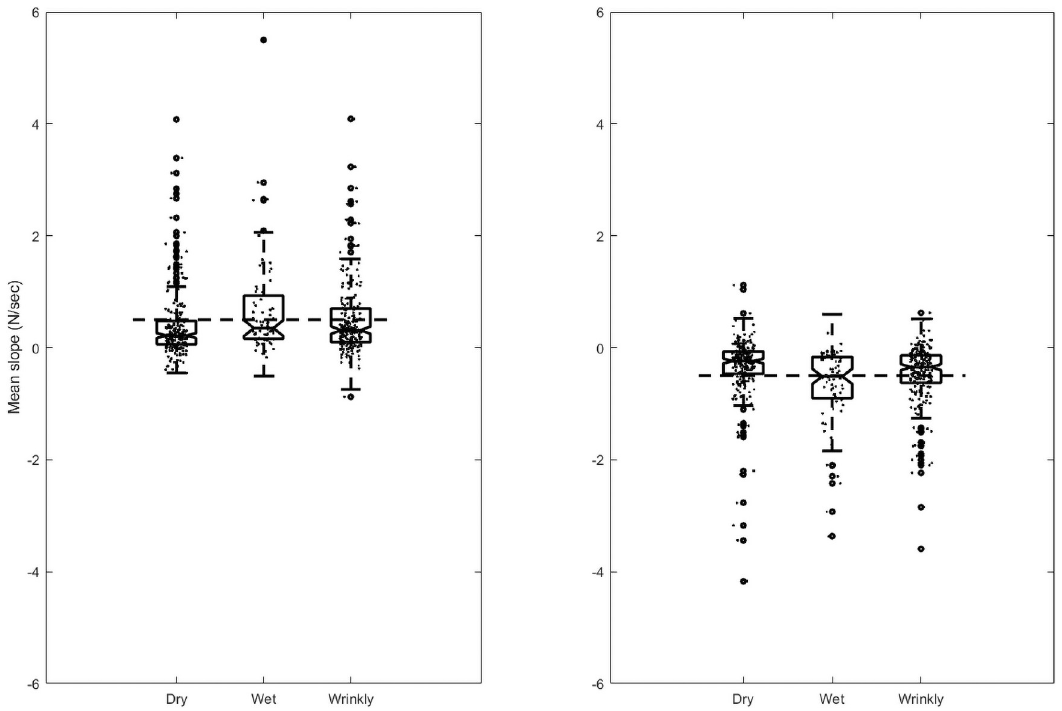
Fig 3. Rate of change of grip force. Boxplot of the rate of change of grip force in the ‘attack’ phase (A) where the target force is rising, and in the ‘decay’ phase (B) where target force is declining.